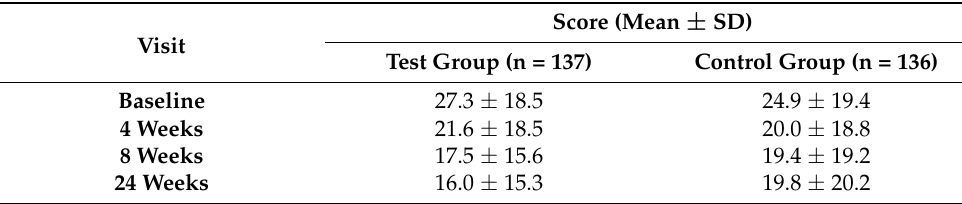
Table 2. The OHIP-49 scores at various study visits.